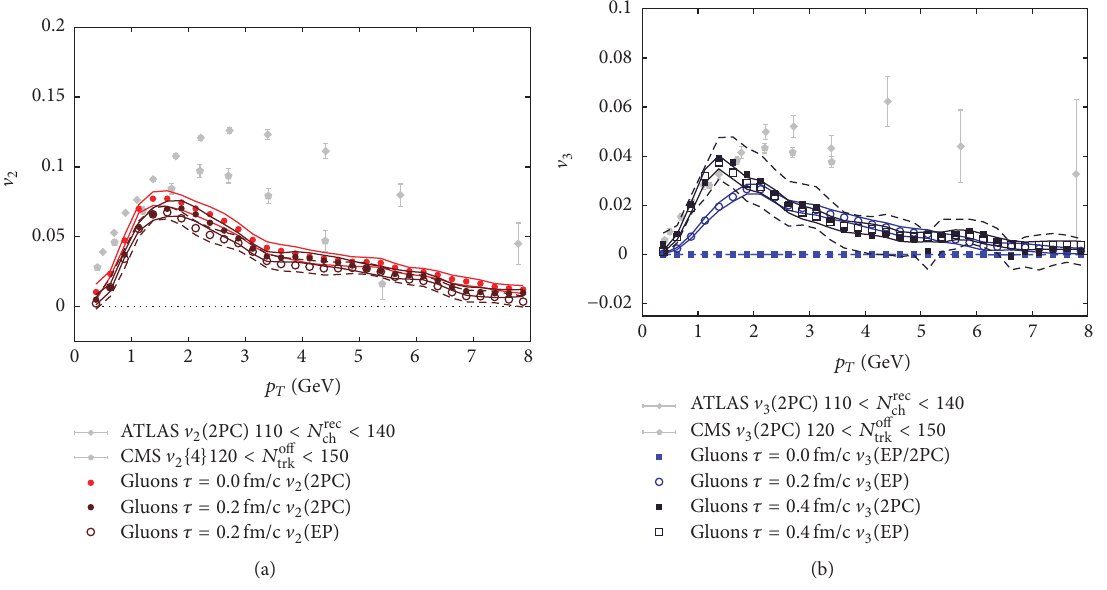
Figure 9: Gluon V 2 (𝑝 𝑇 ) (a) and V 3 (𝑝 𝑇 ) (b) in p+Pb collisions from Yang-Mills simulations, figure obtained from [38] compared to data from ATLAS [63] and CMS collaboration [64] for inclusive